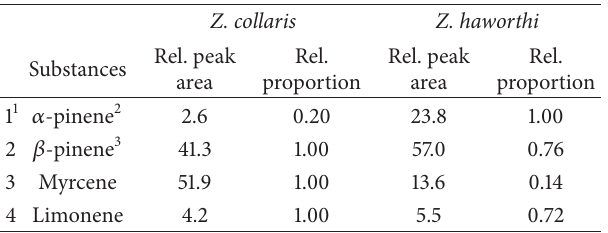
Table1:Substancesfoundintheheadspaceofaflaskcontainingrove beetles of the genus Zyras, which have been teased using a magnetic stir bar. Numbers in the table refer to numbers in Figure 1. Relative proportions of the substances between the beetles were calculated in accordance with [12]. The substance with the highest peak area for each row is the reference (=